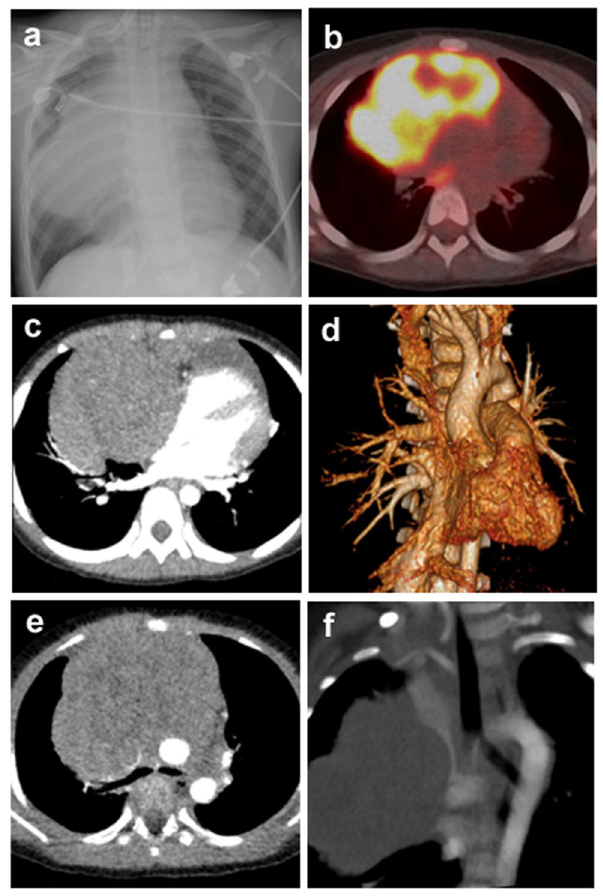
Figure 1. Radiological characteristics of T-LBL/T-ALL involving the mediastinum, case 1. ( a ) Chest X-ray image shows a large mass in the mediastinum. ( b ) PET-CT image shows increased FDG activity in the mediastinum. ( c ) Axial contrast-enhanced CT scan shows the compression of pericardiaum. ( d ) Three- dimensional volume rendered image of contrast-enhanced CT exhibits the compression of pericardiaum. ( e ) Axial contrast-enhanced CT scan shows vascular compression and tracheal encasement of the mass. ( f ) Maximal intensity projection of contrast-enhanced CT reveals the encasement of superior vena